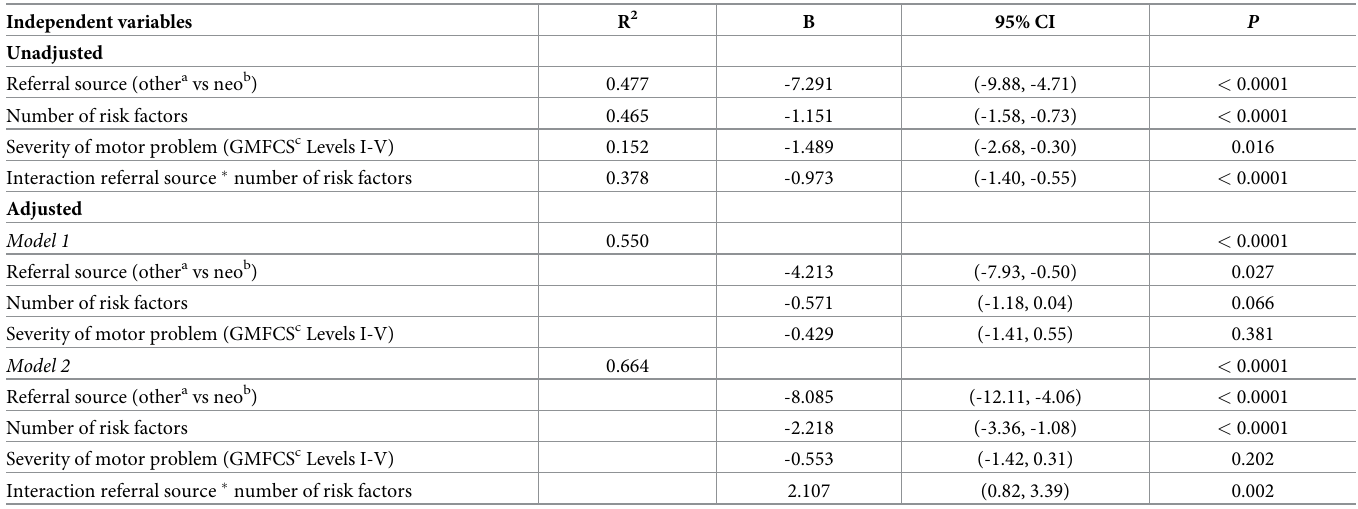
Table 2. Linear regression models.